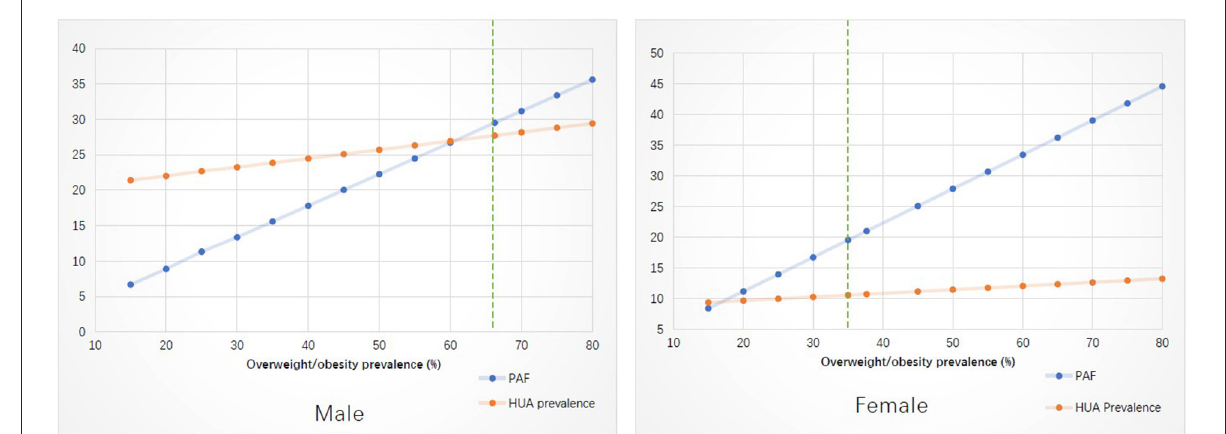
FIGURE1 Stimulation analysis on the effect of changed modifiable risk factors on the prevalence of hyperuricemia. PAF, population attributable fraction; HUA,